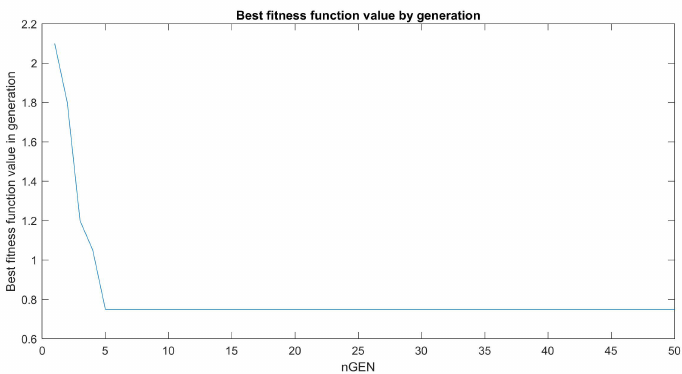
Figure 12. Best fitness function value by generation, generated in the Beacon Calibration Tool.